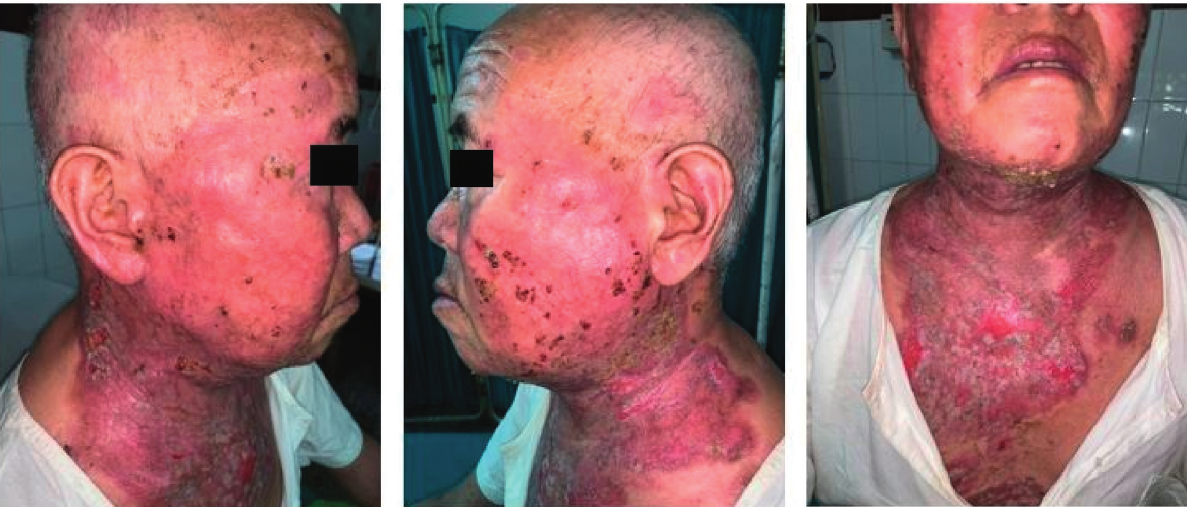
Figure 6: 90% resolution of lesions within 2 weeks of commencing oral acyclovir.